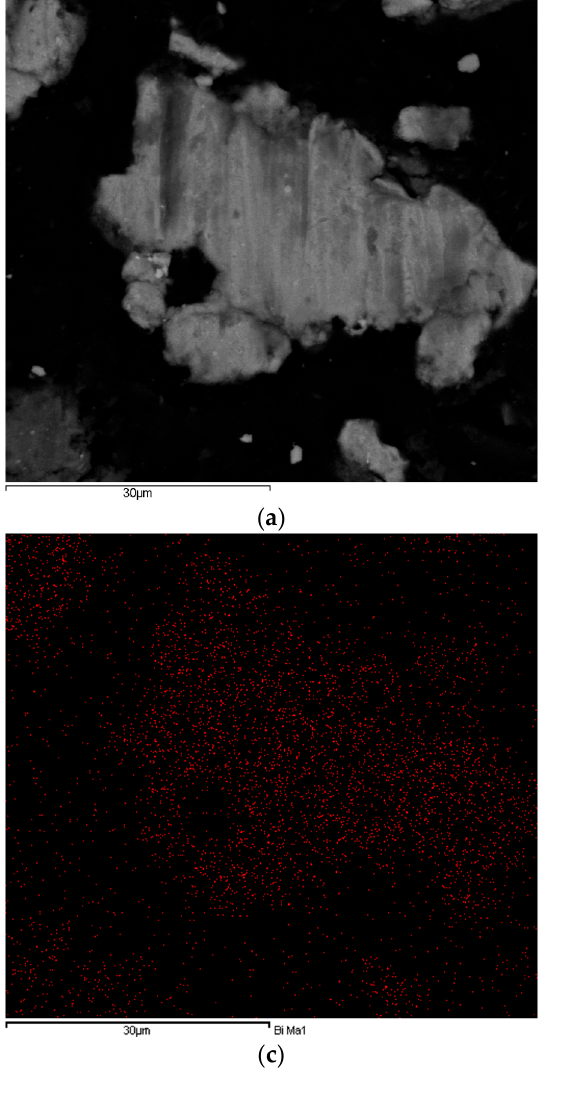
Figure 2. Backscatter SEM micrograph of a cross-sectioned Al-9.25% Bi-0.75% Ni composite particle ( a ) and the corresponding EDS mappings for Al ( b ), Bi ( c ), and Ni ( d ).